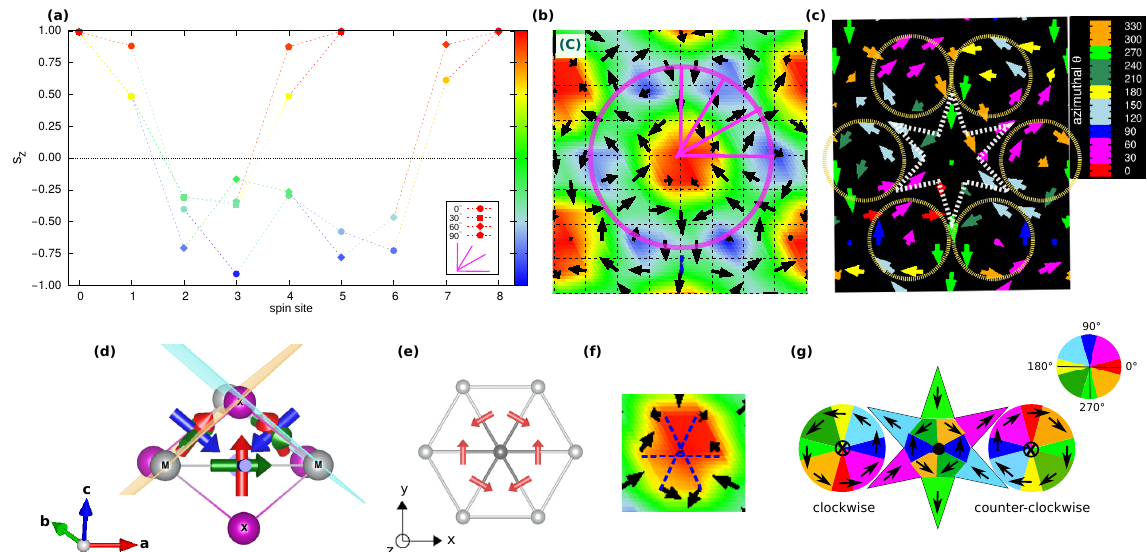
Figure 7. Profile of the out-of-plane component of spins and in-plane spin texture of the C-phase. ( a ) s z component of spins for each magnetic site from the MC simulations, when moving from the upward ( s z = + 1) core (spin site n. 0) of the topological object (A2V) along the radial directions (0 ◦ , 30 ◦ , 60 ◦ and 90 ◦ , purple lines) toward the next-neighbor A2V-cores. This defines the s z profile, which can be regarded to as a discretized polarity p associated with the anti-bi-vortex, when moving from its core to its finite edge, defined by the distance with respect to the nearest-neighbor downward cores ( s z = − 1) of the surrounding vortices; the A2V-radius counts (cid:39) 4 spins ( b ). ( c ) In-plane components of spins; arrows are colored with the azimuthal angle θ ∈ [ 0 ◦ ,360 ◦ ) , defined by the s x and s y components of the spin vector s and highlighting the in-plane spins rotational direction. A schematic representation of the two vortices and anti-bi-vortex together with a color wheel in ( g ) further helps the visualization of the planar orientation of spins. ( d ) Lateral view of the local eigenvectors for each M - X - M - X spin-ligand plaquette on the triangular M -net to help visualization of the non-coplanarity and non- collinearity in the exchange-tensor principal axes. ( e ) In-plane components of the red eigenvector pointing along the X - X direction for each six nearest-neighbor magnetic M - M pair. Specific case here concerns the two-ion anisotropy ( J S ) estimated in monolayer NiI 2 [40] (Table 1). Spins on the nearest-neighbour M sites of the central site orient according to the in-plane projection of the noncoplanar principal axes, as from the zoom on the spin texture of the A2V-core obtained by the MC simulations ( f